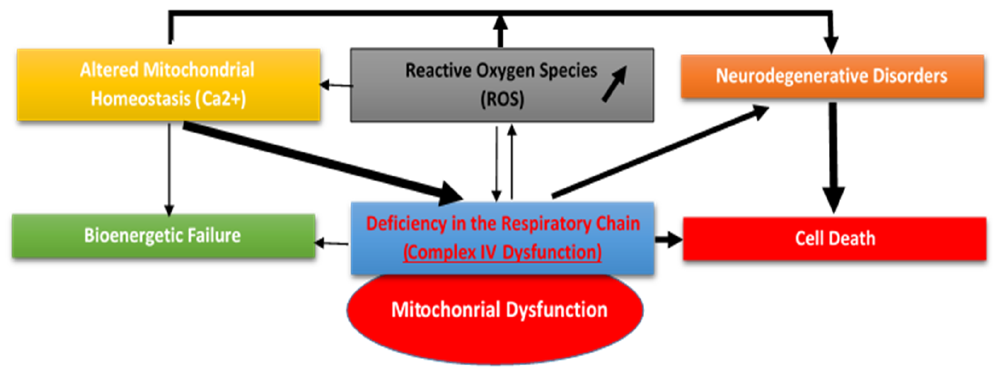
Figure 2. Neurodegenerative disorders related to mitochondrial dysfunction.